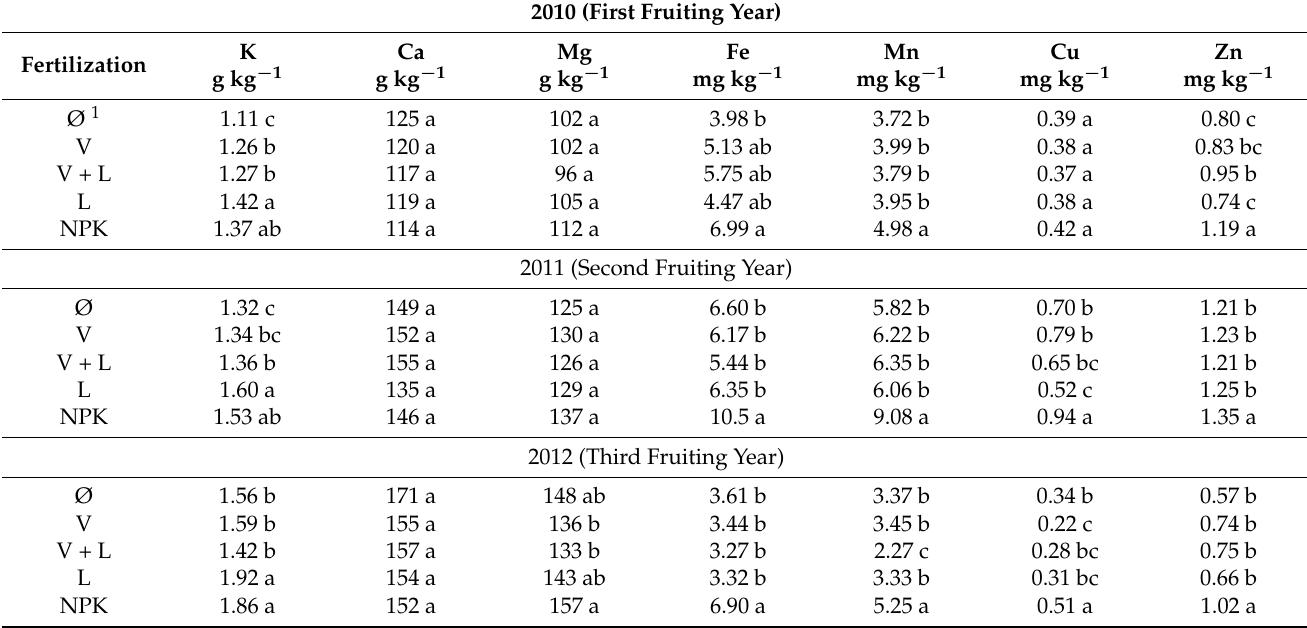
Table 3. Mineral composition of strawberry